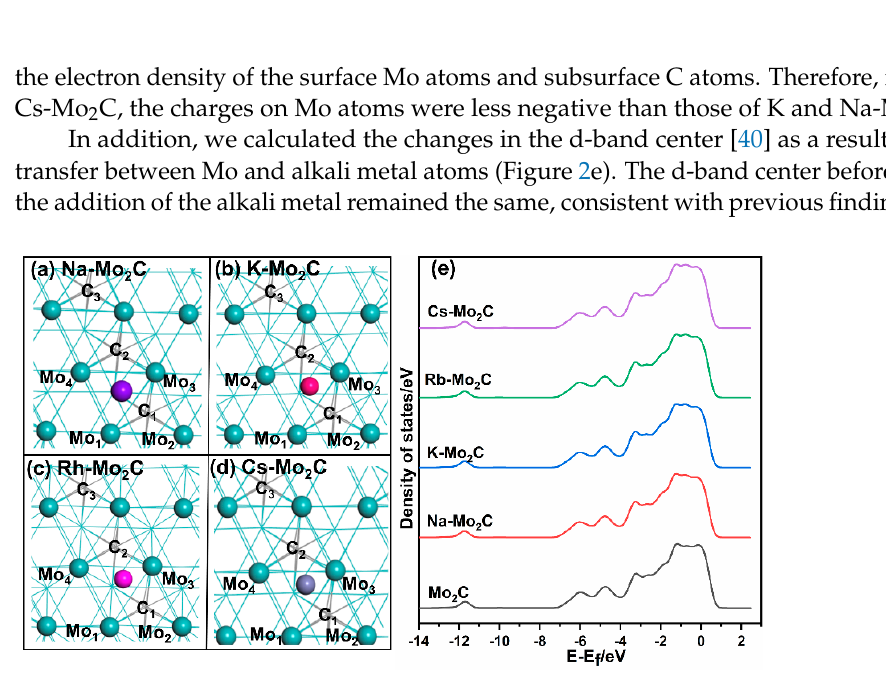
Figure 2. The most stable structure of X − Mo 2 C (001): ( a ) Na − Mo 2 C, ( b ) K − Mo 2 C, ( c ) Rb − Mo 2 C, and ( d ) Cs − Mo 2 C; ( e ) d − band center of Mo atoms on Mo 2 C and X-Mo 2 C (X = Na, K, Rb, and Cs). Color codes: Mo—green, carbon—grey (shown in line model). Table 1. Mulliken charges ( e ) of key atoms in the clean and X-Mo 2 C (X = Na, K, Rb, Cs) *. Catalysts